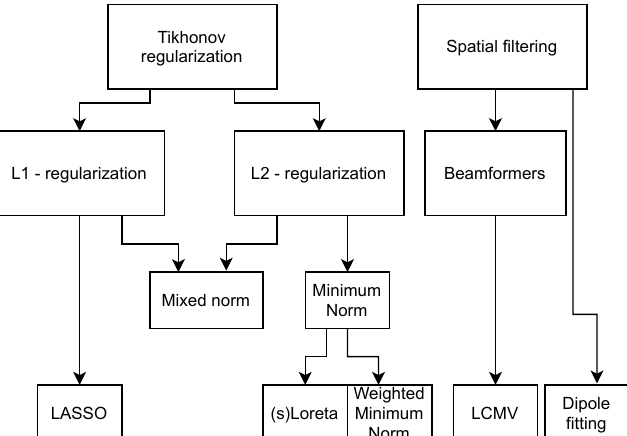
Figure 3. Inverse methods family tree, indicating their